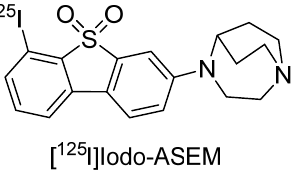
Figure 4. Representative α 7 nAChR radioligands for